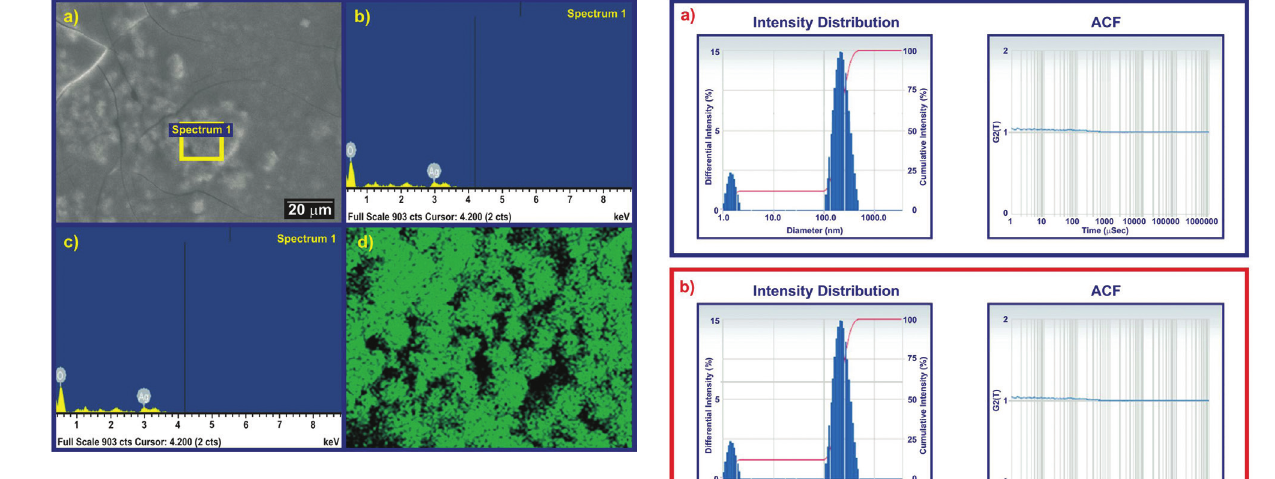
Figure 9: EDS image of synthesized silver nanoparticles from: (a,b) Averroh bilimbi leaf extract, (c,d) Plum fruit extract. Table 1: EDS Atomic percentage of formation of silver nanoparticles. Element